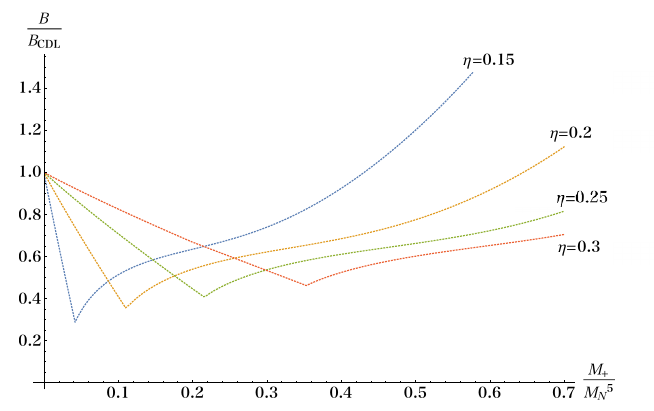
Figure 1 . Plots of the ratio B=B CDL as functions of the seed mass M + =M (5)